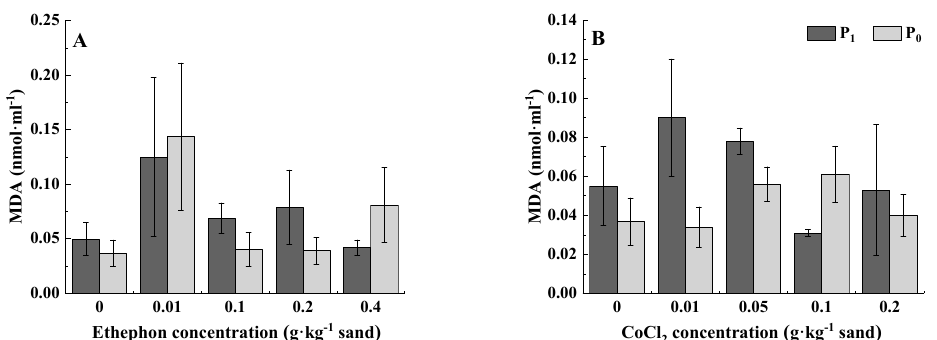
Figure 4. Differences in the MDA activity ( A , B ) between the two groups, namely phosphorus supply (1 mmol·KH 2 PO 4 , (1 mmol · KH 2 PO 4 , P 1 ) and no phosphorus supply (0 mmol · KH 2 PO4, P 0 ), treated with different P 1 ) and no phosphorus supply (0 mmol·KH 2 PO4, P 0 ), treated with different concentrations of exogenous additives concentrations of exogenous additives (ethephon and CoCl 2 (ethephon and CoCl 2 ).